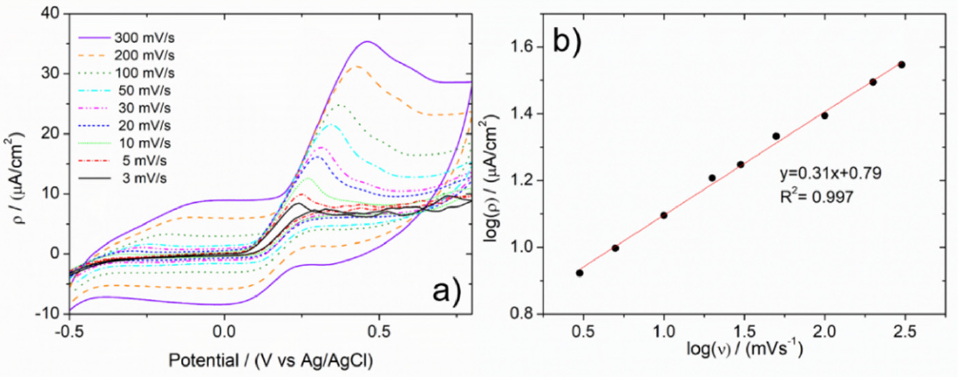
Figure 4. ( a ) CV scans of 0.02 M ascorbic acid in 0.1 M KH 2 PO 4 solution at 3 min A-NPG electrode as a function of scan speed; ( b ) plot log( ρ ) vs. log( ν ) showing linearity trend and diffusive control process.